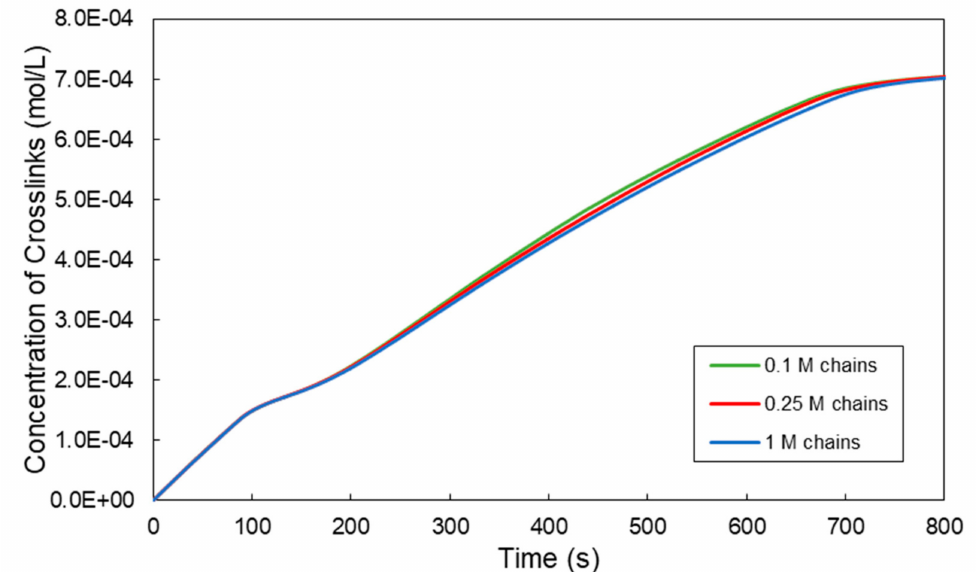
Figure 7. Effect of the initial sample size on the time evolution of the crosslinks concentration for a HA-Tyr solution (i.e., 1.75% w/v , MW = 90 kDa, 0.124 units/mL HRP and 728- µ M H 2 O 2 )